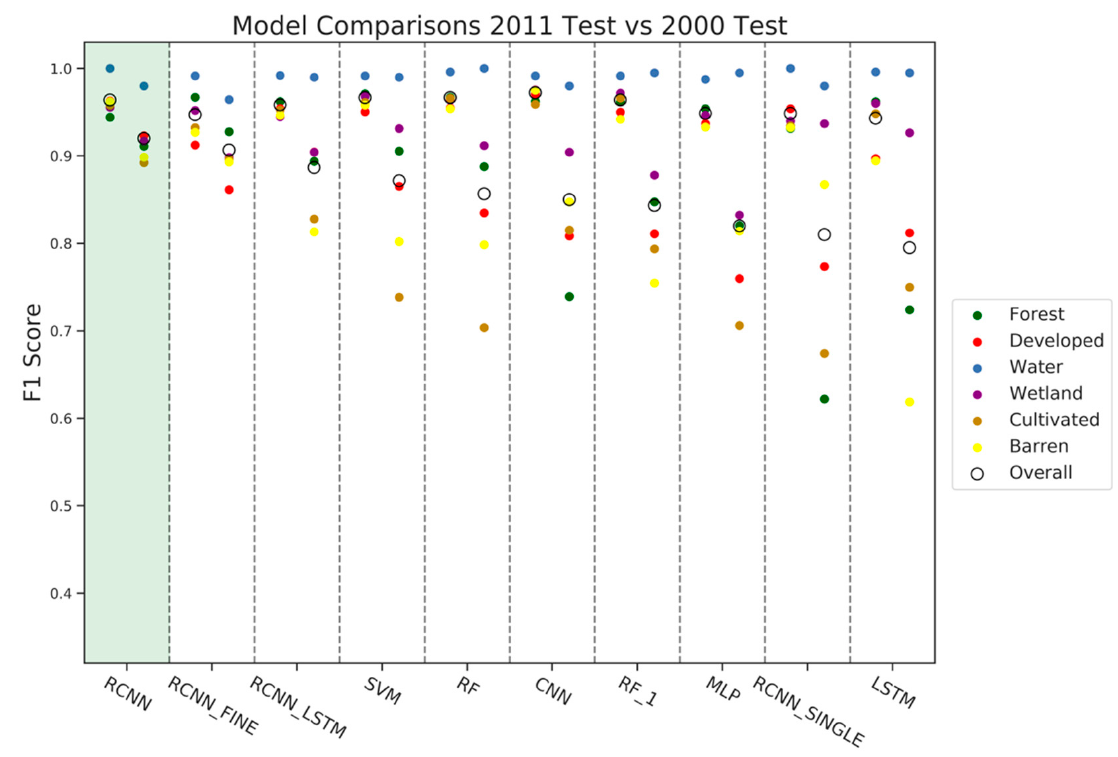
Figure 5. Comparison of model accuracy ordered from left to right by overall accuracy from the 2000 test set. F1 score is shown for each class. F1 score is the harmonic mean of producer’s and user’s accuracy. The left side of each model’s column is the 2011 test data and the right side is the 2000 test data. Points are colored by class.